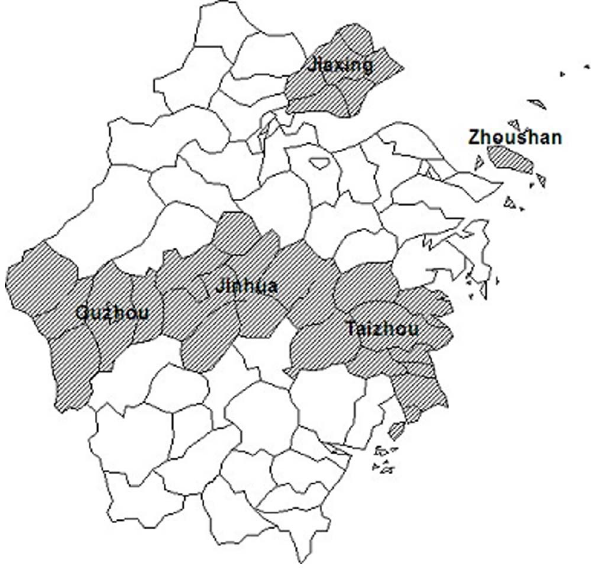
Figure 1. The geographical distribution of the 5 regions in